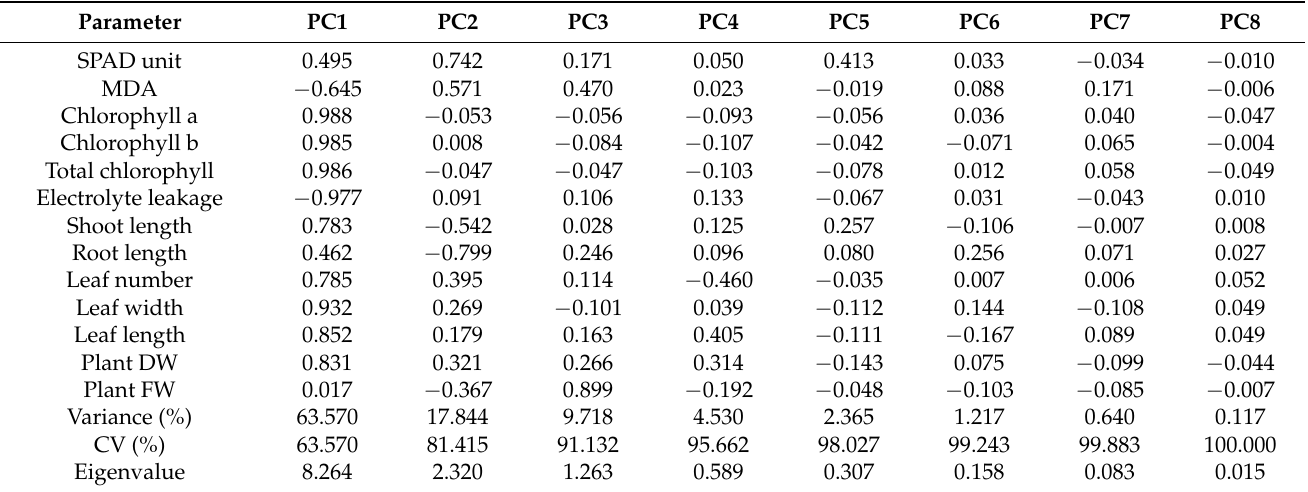
Table 2. Loading variables, variance, cumulative variance and eigenvalues from PCA analysis of growth and physiological parameters after heat stress of KDML105 seedlings.